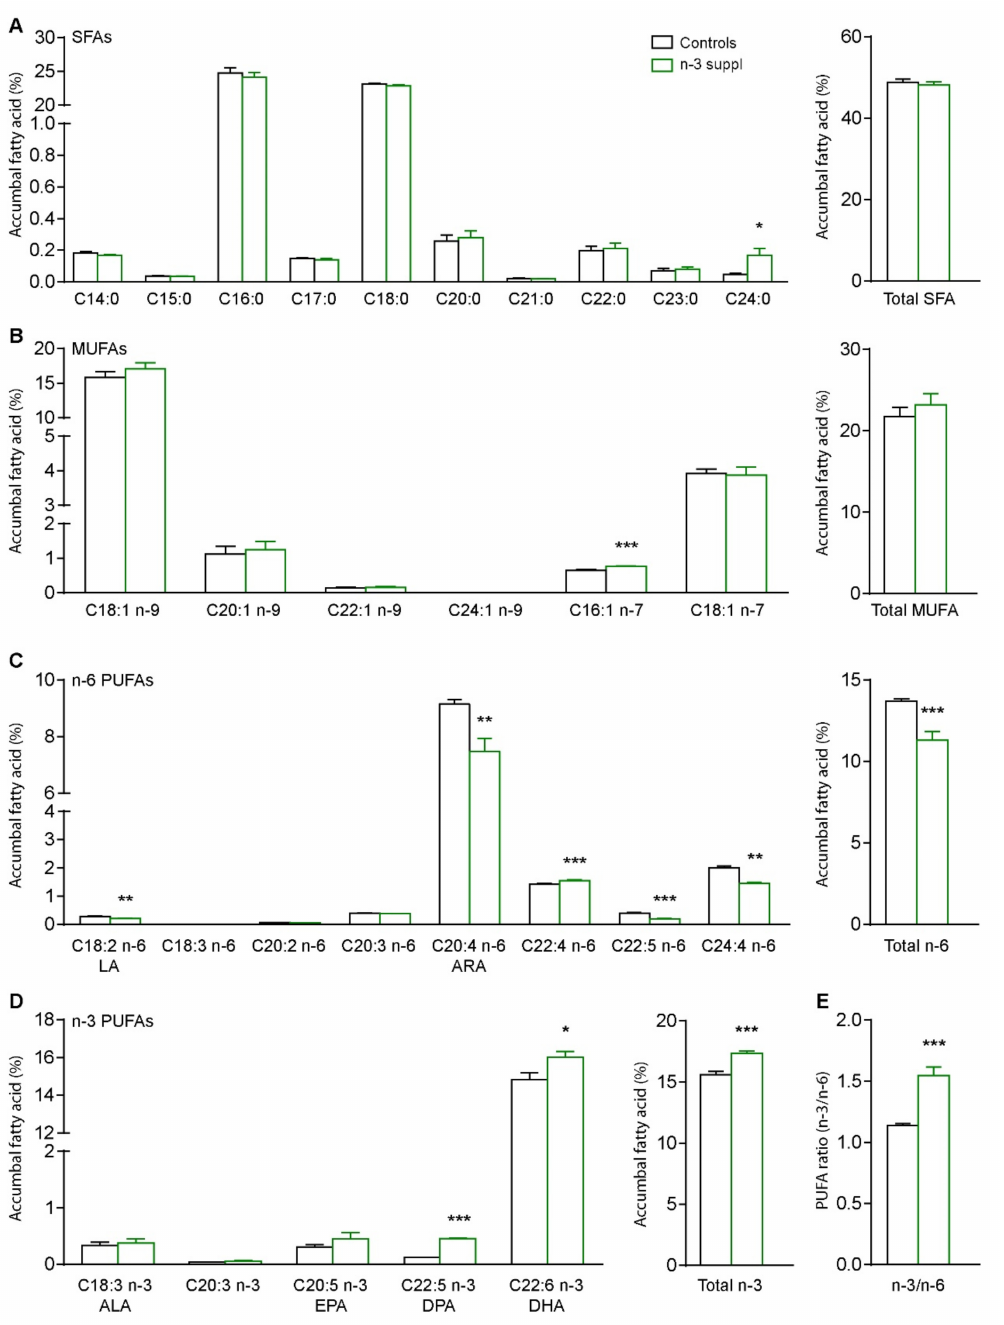
Figure 2. Accumbal fatty acid profiles of control and n-3-supplemented (n-3 suppl) mice. ( A ) Sat- urated fatty acids (SFA). ( B ) Mono-unsaturated fatty acids (MUFAs). Polyunsaturated fatty acids (PUFAs) of the n-6 ( C ) and n-3 ( D ) families. ( E ) Ratio of n-3 over n-6 PUFAs. LA: linoleic acid, ALA: alpha-linolenic acid, ARA: arachidonic acid, EPA: eicosapentaeonic acid, DPA: docosapentaenoic acid, DHA: docosahexaenoic acid. Unpaired t -tests. * p < 0.05, ** p < 0.01, and *** p < 0.001 vs. control. Histograms represent mean ±